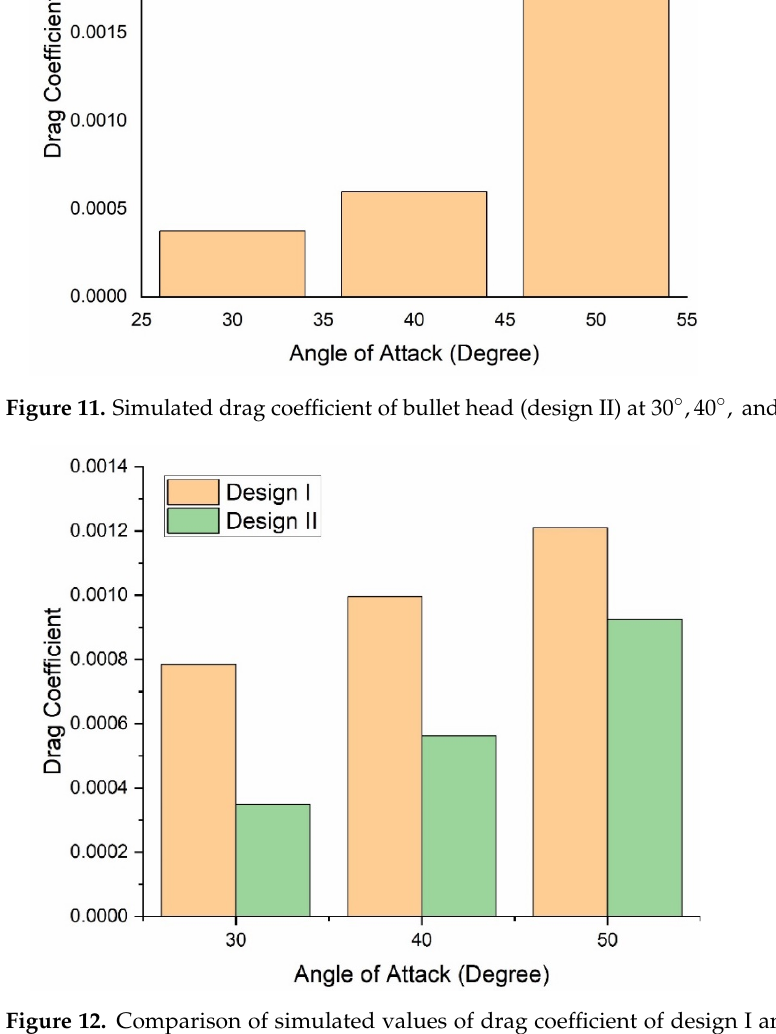
Figure 11. Simulated drag coefficient of bullet head (design II) at 30°, 40°, and 50° angle of attack. Table 5. Simulated and experimental values of drag coefficient of design II of bullet heads at varying angles of attack.